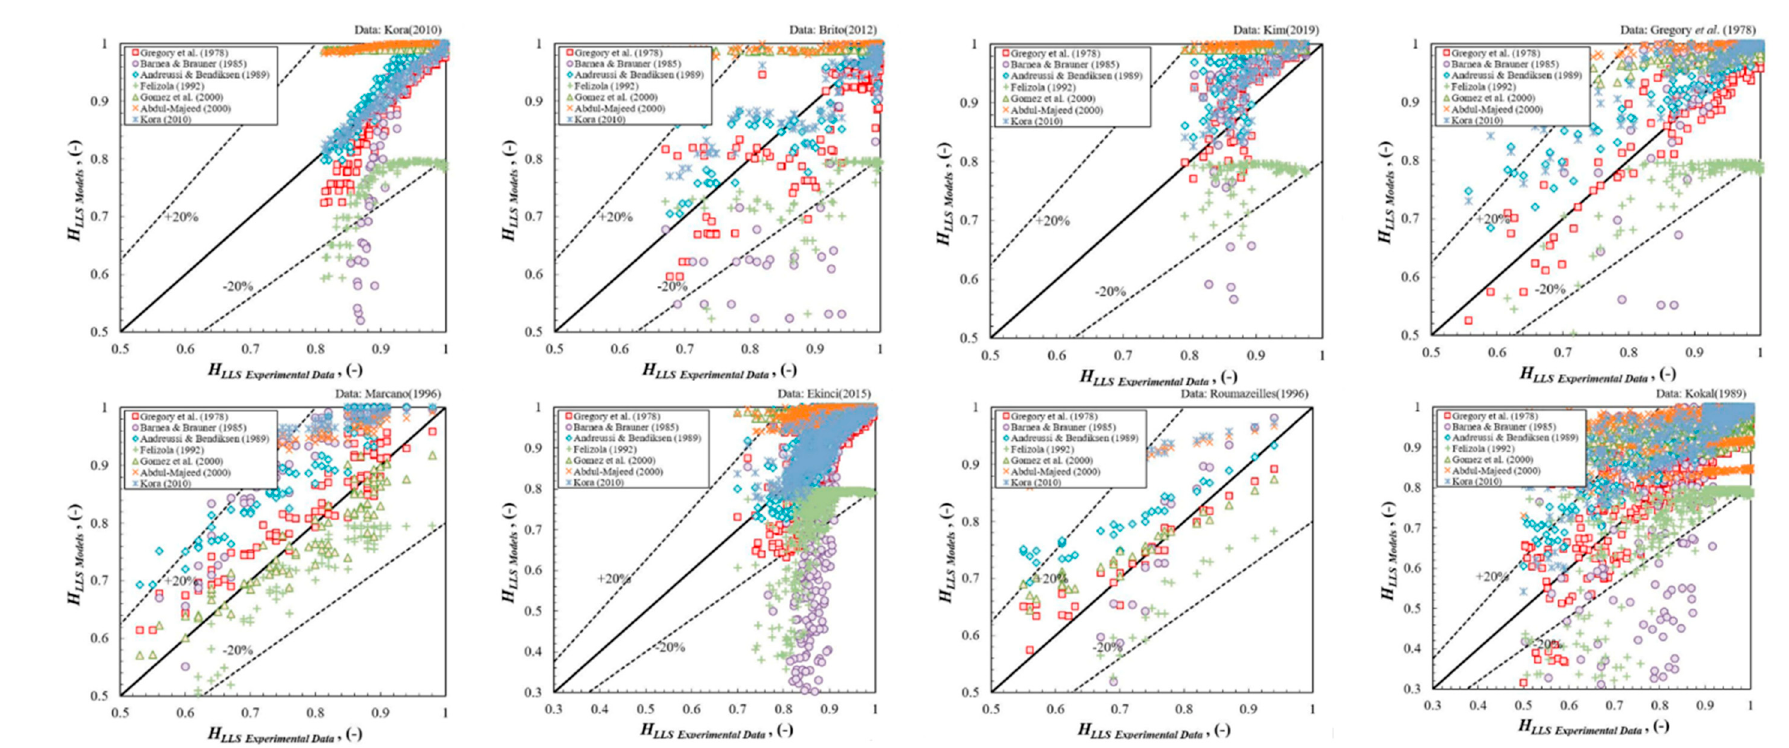
Figure 8. Slug liquid holdup models